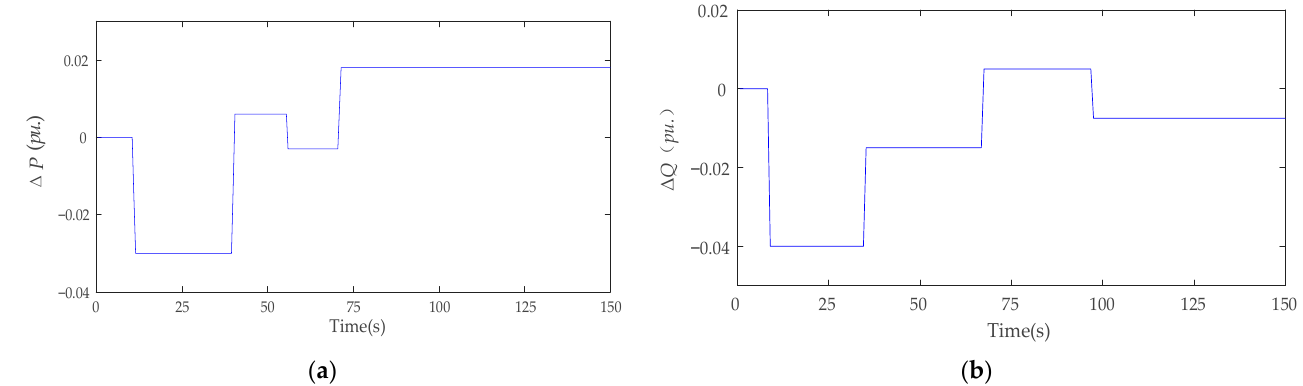
Figure 15. Load power disturbance: ( a ) load active power disturbance; ( b ) load reactive power dis- Figure 16. Performance of frequency control under load power disturbance. turbance. Figure 16. Performance of frequency control under load power disturbance.